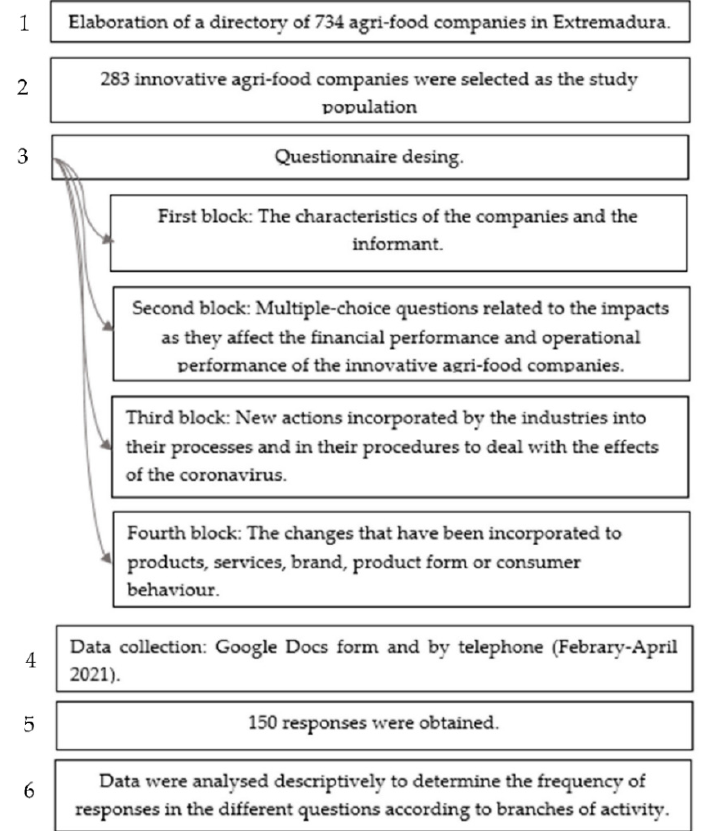
Figure 1. Research design.